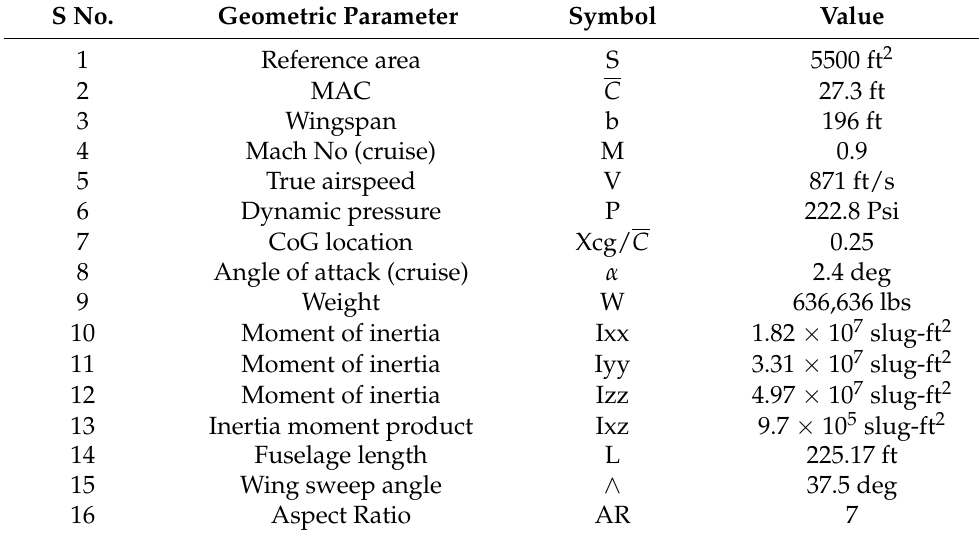
Table 2. Geometric parameters of BOEING 747-200 aircraft